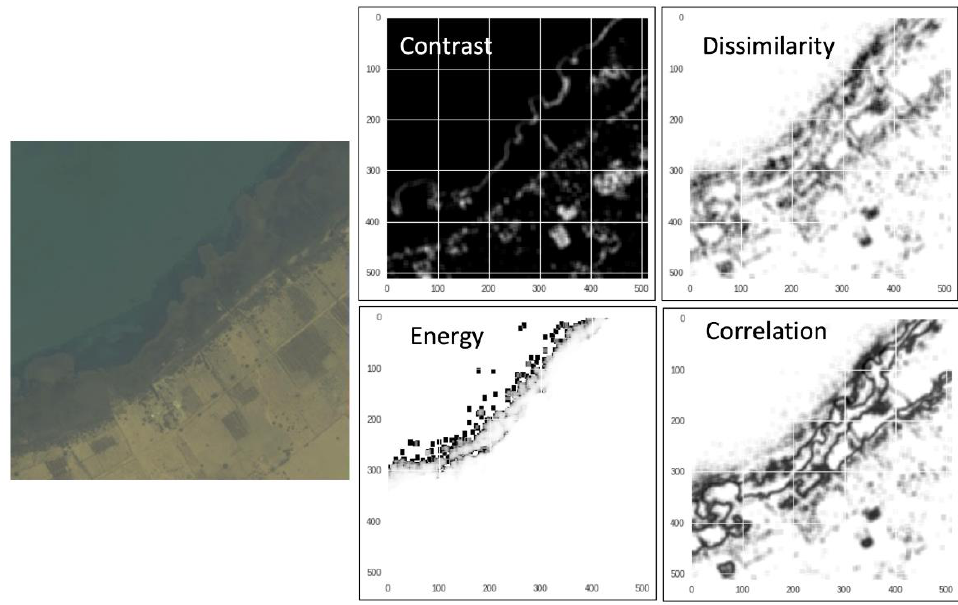
Figure 6. Examples of GLCM texture features: contrast, dissimilarity, energy, and correlation, which are calculated from the raw pixel values of the 8-band multispectral WorldView-2 imagery.